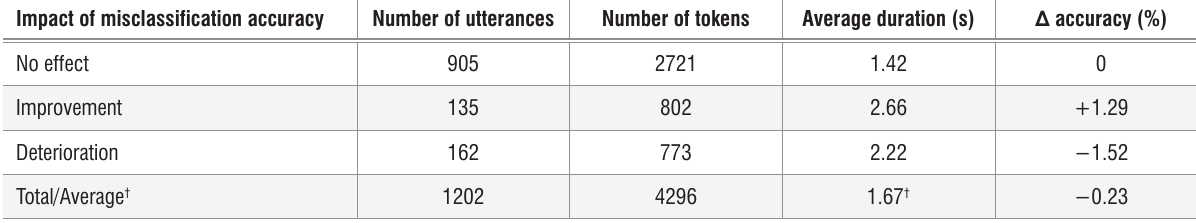
Analysis of accent misclassifications for the parallel per-utterance accent identification system using accent-specific acoustic models Impact of misclassification accuracy